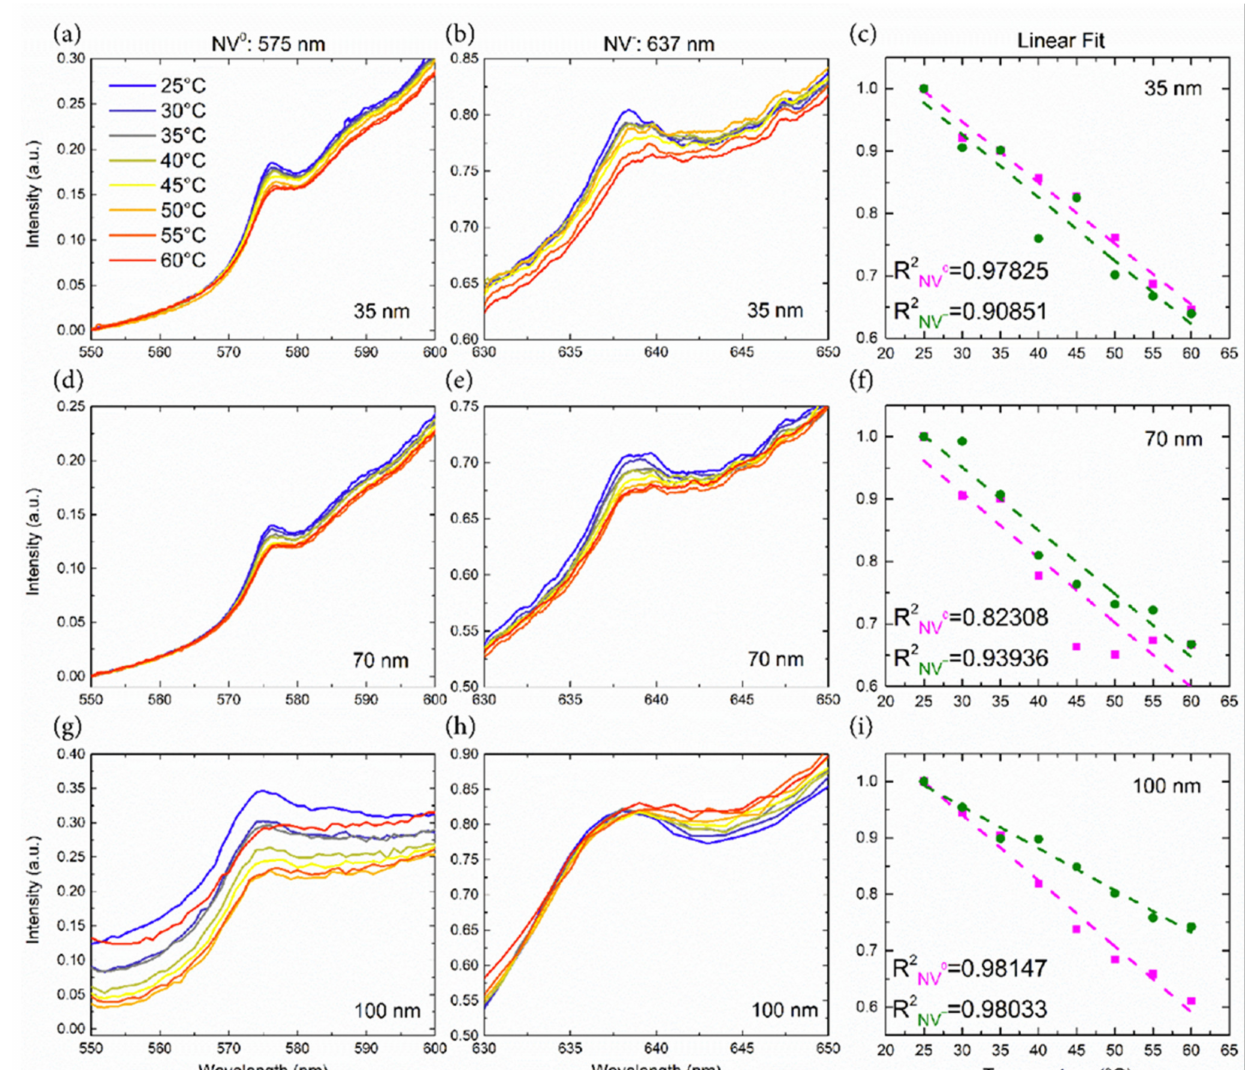
Figure 2. Fluorescence spectra of NV 0 and NV − centres in HPHT nanodiamonds of 35 nm ( a , b ), 70 nm ( d , e ) and 100 nm ( g , h ) for temperatures from 25 ◦ C to 60 ◦ C. The dependence of the maximum fluorescence intensity on temperature ( c , f , i ) is obtained through normalization and using a Gaussian model. A linear fit gives R 2 values are 0.97825, 0.82308 and 0.98147 for the NV 0 centre and 0.90851, 0.93936 and 0.98033 for the NV − centre, for nanodiamonds of 35 nm, 70 nm and 100 nm,